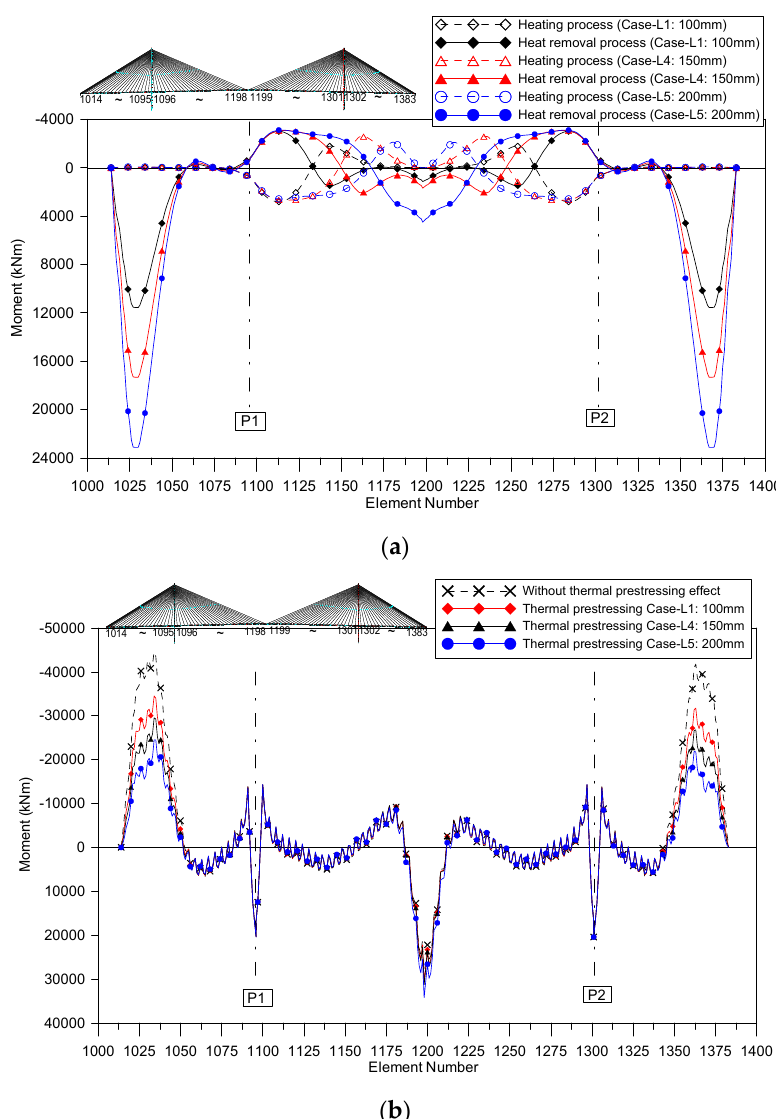
Figure 12. Girder moments for various elongation lengths. ( a ) Moments generated by heating and heat removal processes; ( b ) Moments after completed construction.